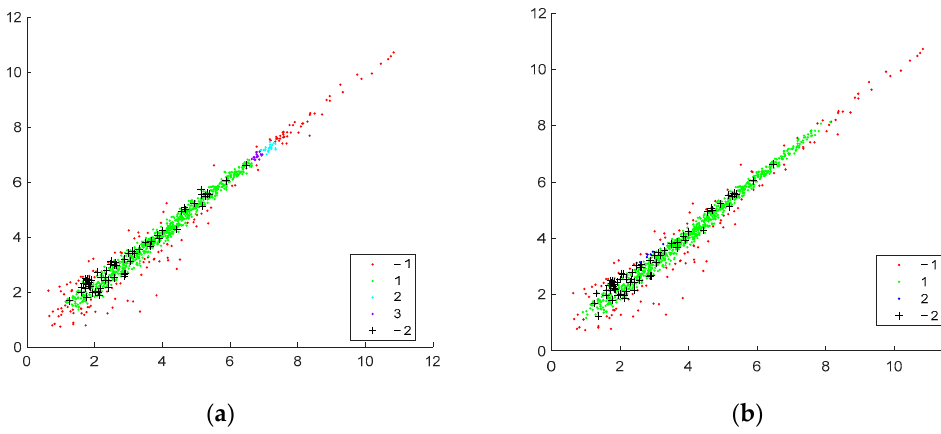
Figure 7. Clustering of the 9th batch, the batch of 1022; Tstd = 0.3. ( a ) Euclidean distance, 62 std genes. ( b ) Mahalonobis distance, 63 std genes.